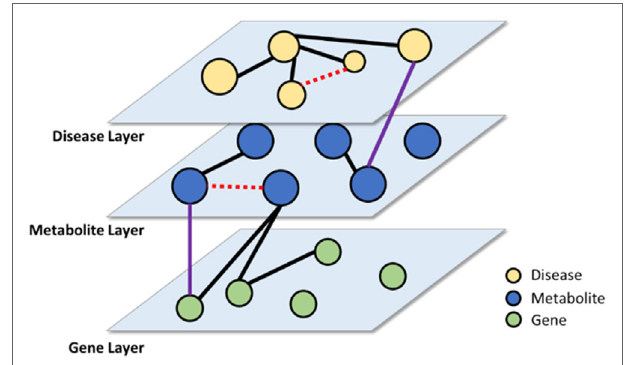
FigUre 12 | Conceptual architecture of multi-layer analysis of knowledge